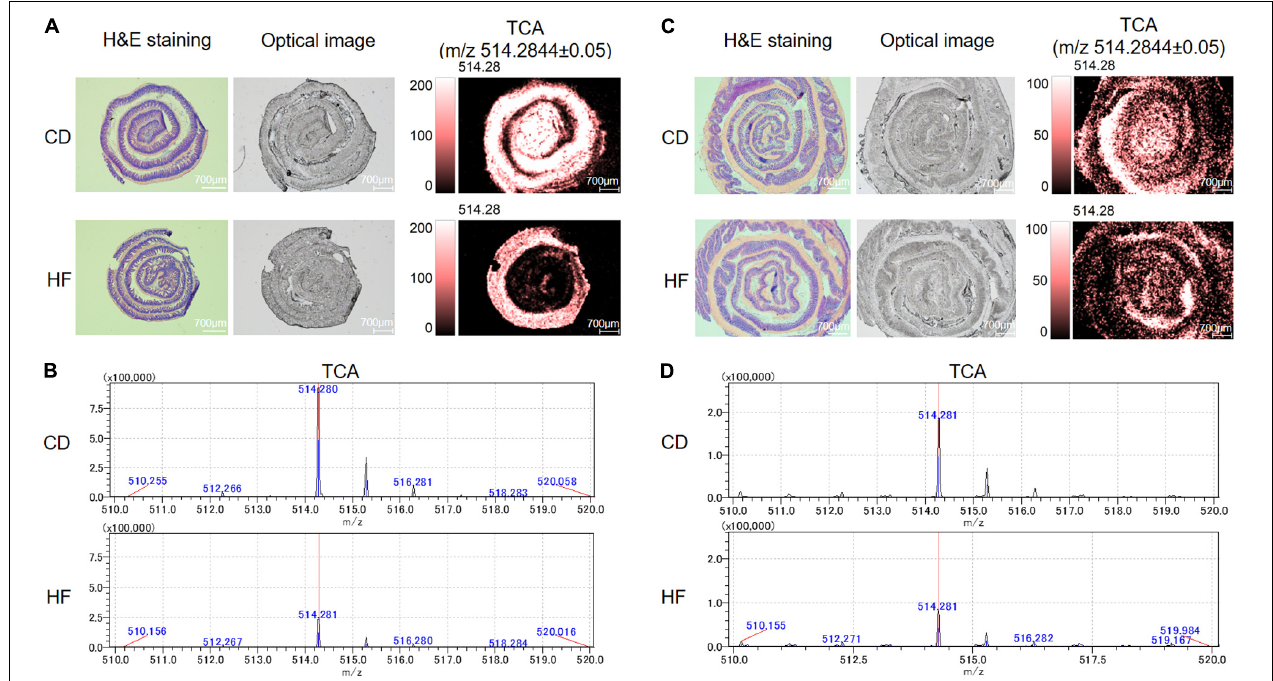
FIGURE 3 | Detection of TCA distributed within the regions of the ileum and colon by MALDI-MSI. (A) MS ion images of the spatial distribution of TCA from ileum tissue. Experimental m / z values were presented in parentheses. TCA ( m / z 514.2844 ± 0.05). All ion images were normalized to the 9-AA matrix signal. (B) MALDI-MSI single-pixel mass spectra of TCA from ileum tissue. (C) MS ion images of the spatial distribution of TCA from colon tissue. Experimental m / z values were presented in parentheses. TCA ( m / z 514.2844 ± 0.05). All ion images were normalized to the 9-AA matrix signal. (D) MALDI-MSI single-pixel mass spectra of TCA from colon tissue. CD, control diet group; HF, high-fat diet